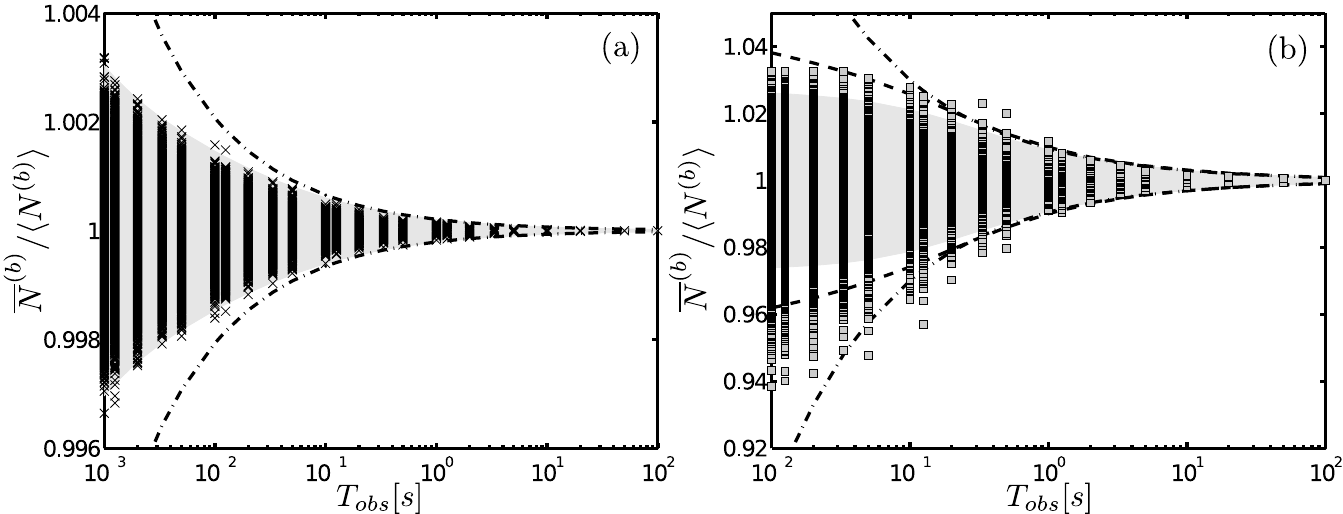
Fig 2. Comparing the predictions of the analytic expresions with stochastic simulations. We show the time-dependence of the normalized average numbers of bound particles, N ( b ) , obtained from stochastic simulations (symbols) and of the region defined by 1 (cid:11) 2 D r ð N ð b Þ Þ with D r ð N ð b Þ Þ computed in various ways. The dashed-dotted curves correspond to Eq (7) with τ ( b ) given by Eq (12). (a) The fr limit holds. The shaded area is computed using Eq (24). (b) The fd limit holds. Eq (22) is used to compute the shaded area. The error derived from Eq (27) is also shown (dashed curve).